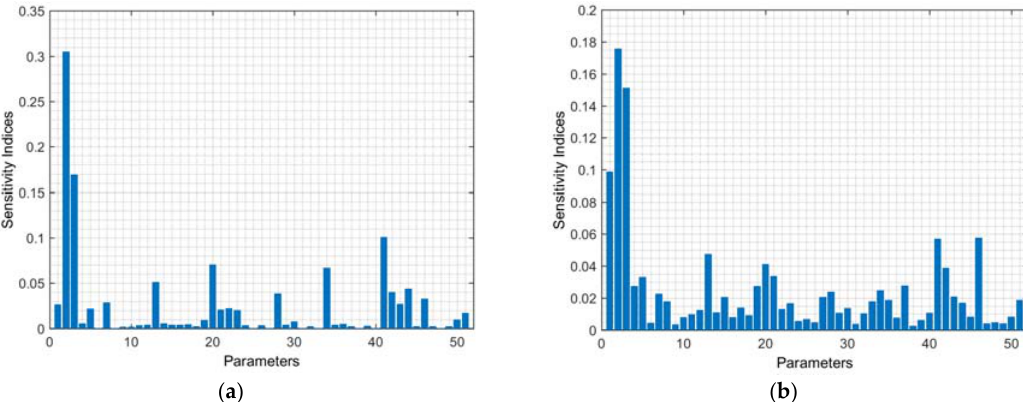
Figure 2. Sensitivity indices of ( a ) Antibody Concentration ( b ) Other Measured Metabolites Concentration to the parameters in the CHO cell model. In both Figure 2a,b, Parameters 1 to 4 correspond to the four process variables and parameter 5 to 51 correspond to the 47 kinetic parameters.